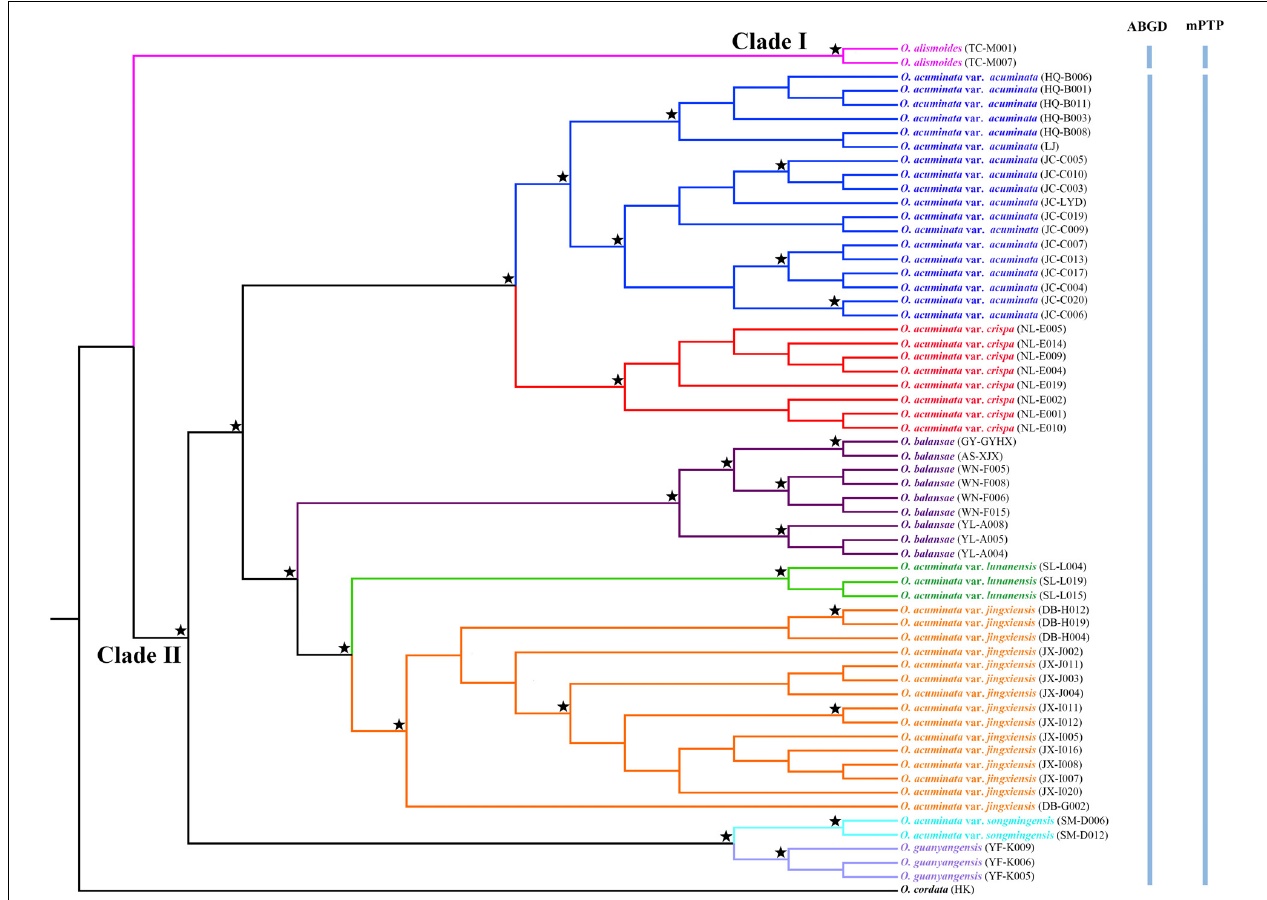
FIGURE 3 | Phylogenetic relationships between Ottelia acuminata and closely related species based on Maximum likelihood (ML) and Bayesian inference (BI) of complete plastomes. Well-supported nodes (BS > 90% and PP > 0.95) are indicated with a star. Species delimitation schemes proposed by automatic barcode gap discovery (ABGD) and multi-rate Poisson tree processes model (mPTP) are reflected on the tree